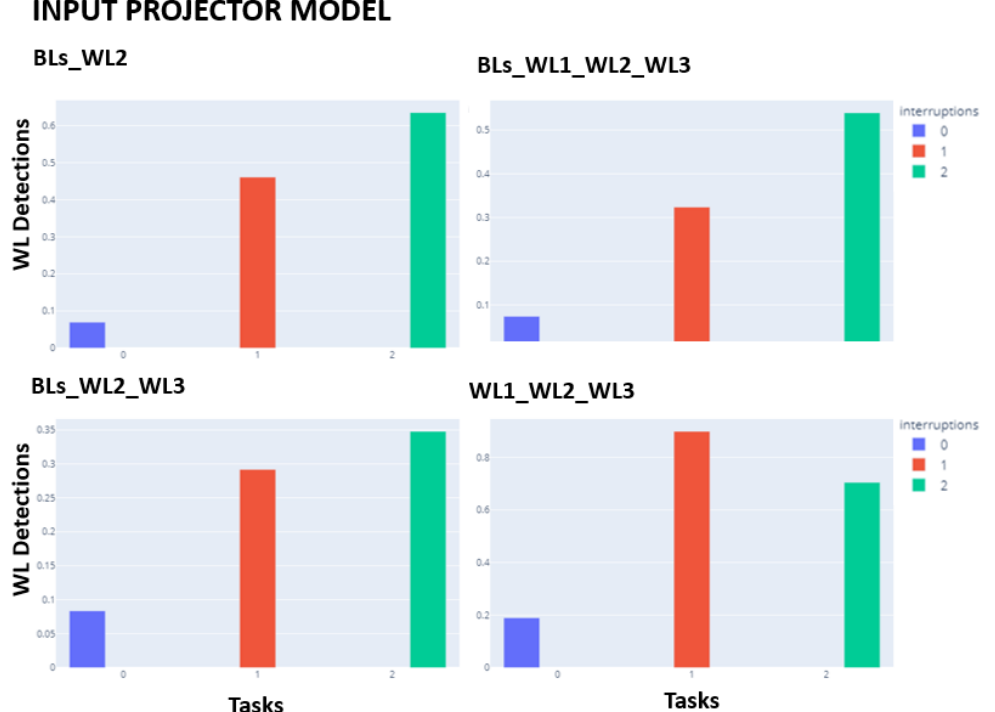
Figure 4. FRAM tasks barplots of WL predictions for the input projector model.